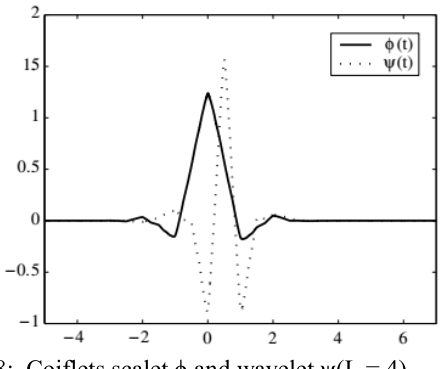
Figure 6: Symmlets wavelets